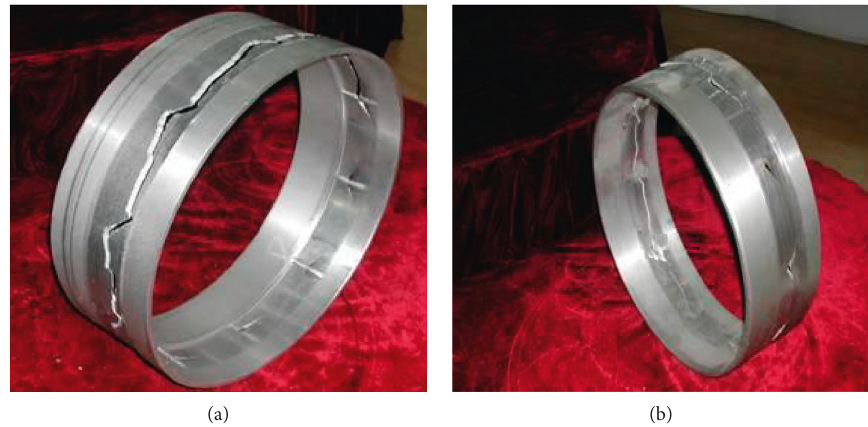
Figure 19: Crack phenomenon in offset spinning. (a) Sample with an offset value of 2.5 mm and (b) sample with an offset value of 3.5mm.